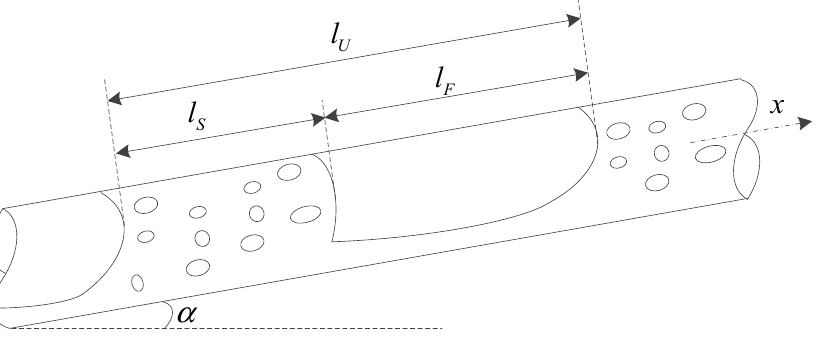
Figure 1. Control volume for the slug unit.